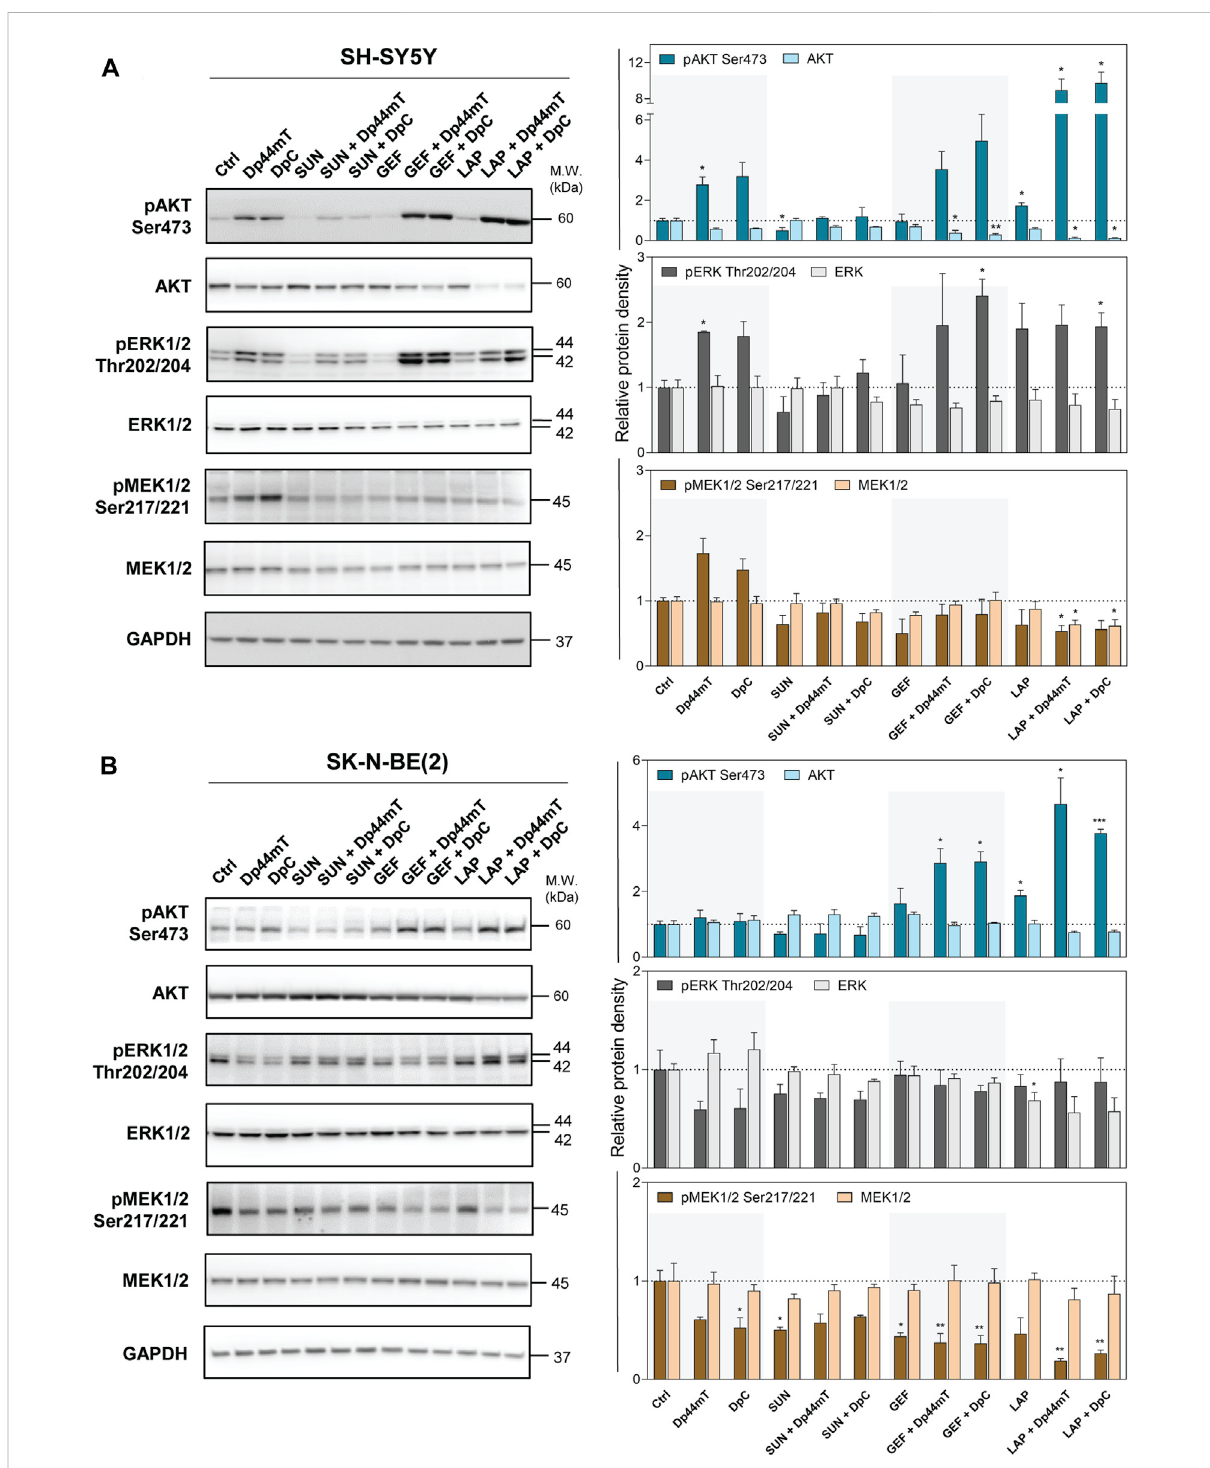
FIGURE 7 WesternblottingofAKT,ERK1/2,andMEK1/2proteinkinases.ThechangesinthetotalproteinlevelsandphosphorylationofAKT(Ser473),ERK1/2(Thr202/ 204), and MEK1/2 (Ser 217/221) were detectedin SH-SY5Y (A) and SK-N-BE(2) (B) cells after a 72-hour incubation with either a control medium or a medium containing the drugs, including TKIs (SUN, GEF, or LAP) and thiosemicarbazones (Dp44mT or DpC) alone or in combination. The drugs were used at concentrations of IC 50 for 72 h as listed in Table 2. Representative blots (left) and their densitometric quanti fi cation (right) of three independent experimentsareshown.Thedataarepresentedasmean±SD( n =3)normalizedtoGAPDHthatwasusedastheprotein-loadingcontrol.* p < 0.05,** p < 0.01, *** p < 0.001relativetotheuntreatedcontrolsamples;the p valueswereevaluatedusingWelch ’ sANOVAfollowedbyDunnett ’ sT3multiplecomparisonstest. The dotted horizontal line in the graph represents the corresponding protein levels detected in the control